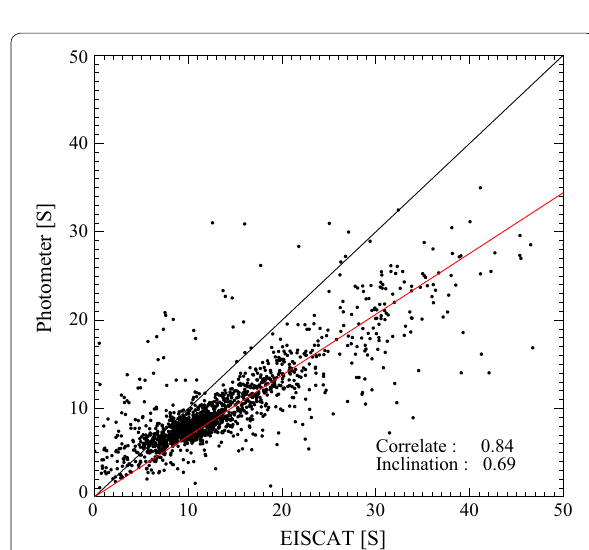
Fig. 9 Scatter plot of height-integrated Pedersen conductivity for October 11, 2002; scatter plot of the height-integrated Pedersen conductivity derived with the EISCAT UHF radar (abscissa) and the photometer (ordinate)